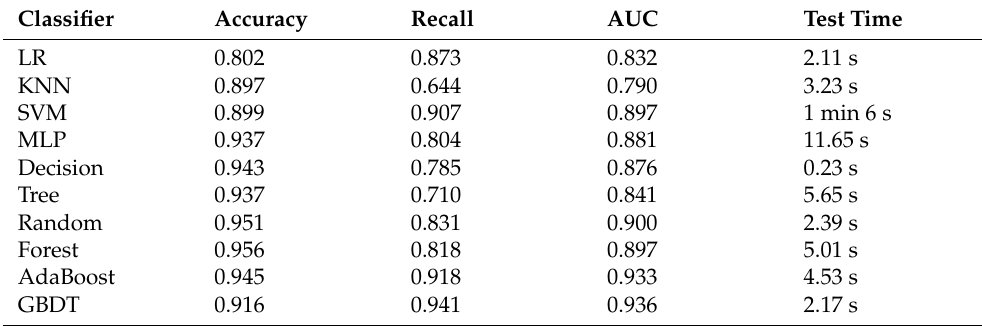
Table 4. The evaluation results of classifier performance.